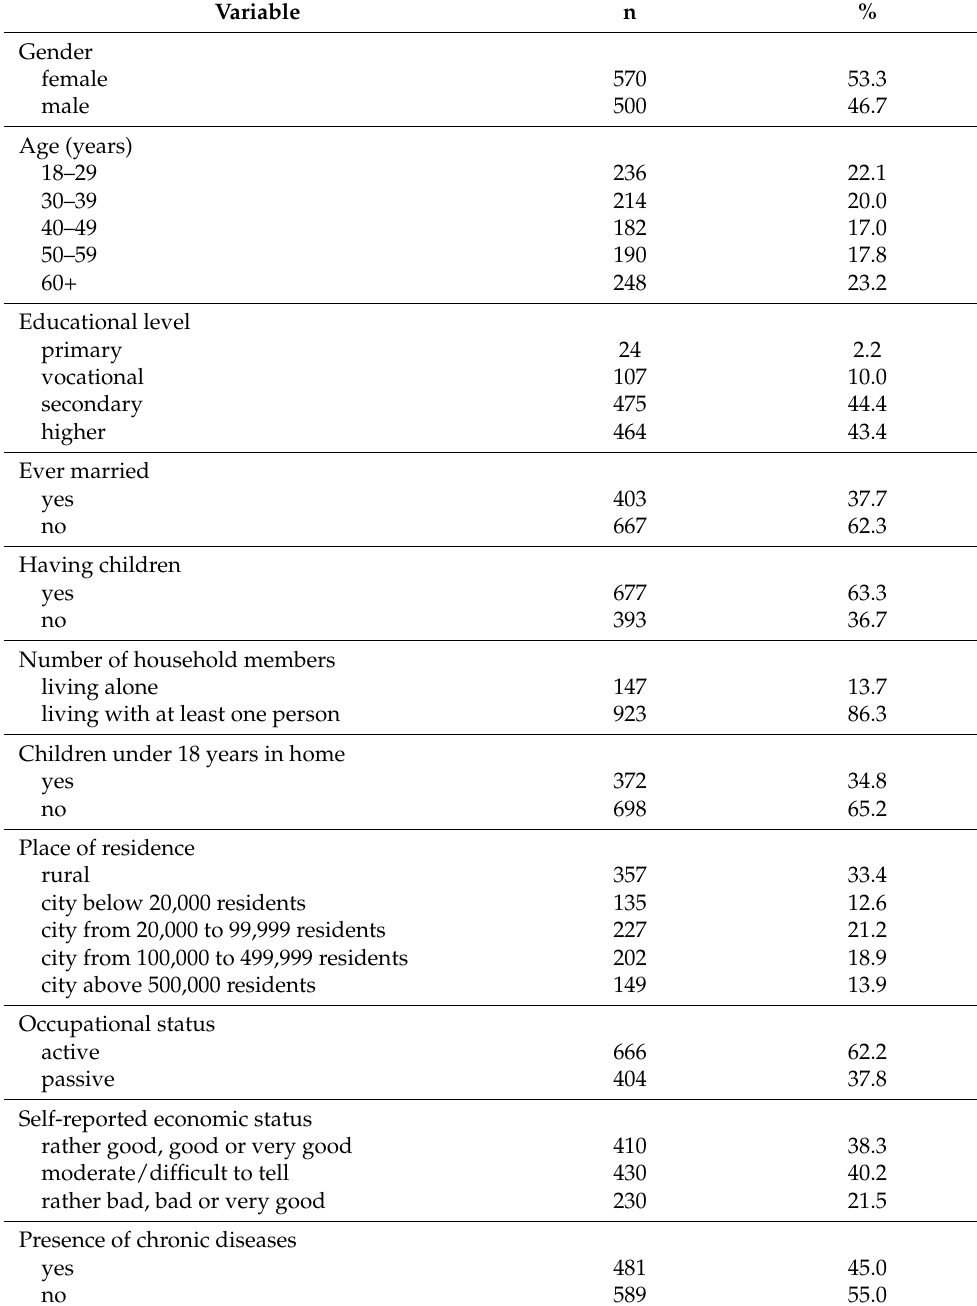
Table 1. Characteristics of the study population (n =